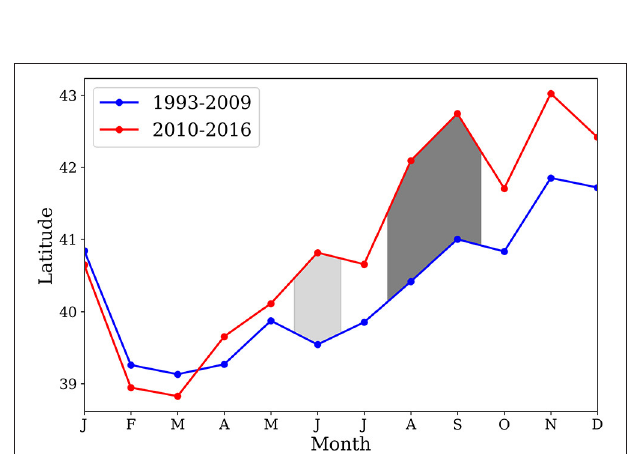
FIGURE 12 | Monthly time series of the southernmost latitude of the FOI. Red and blue curves show the 2010–2016 and 1993–2009 average, respectively. Dark gray and light gray show the differences are significant with p < 0.05 and p < 0.1,